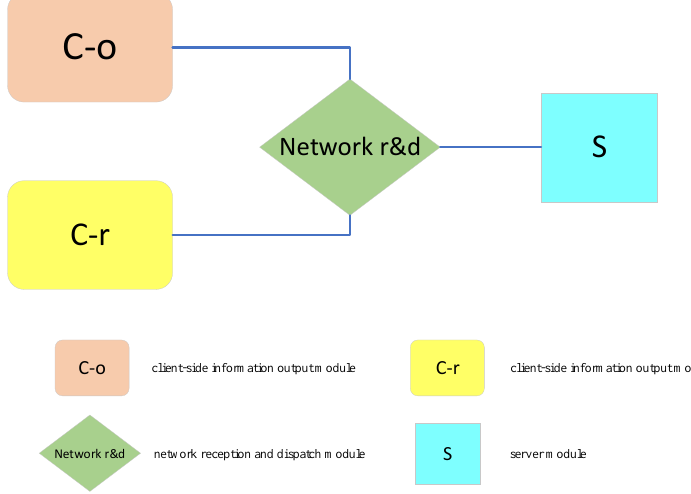
Figure 6. The modules of the flight reservation system.